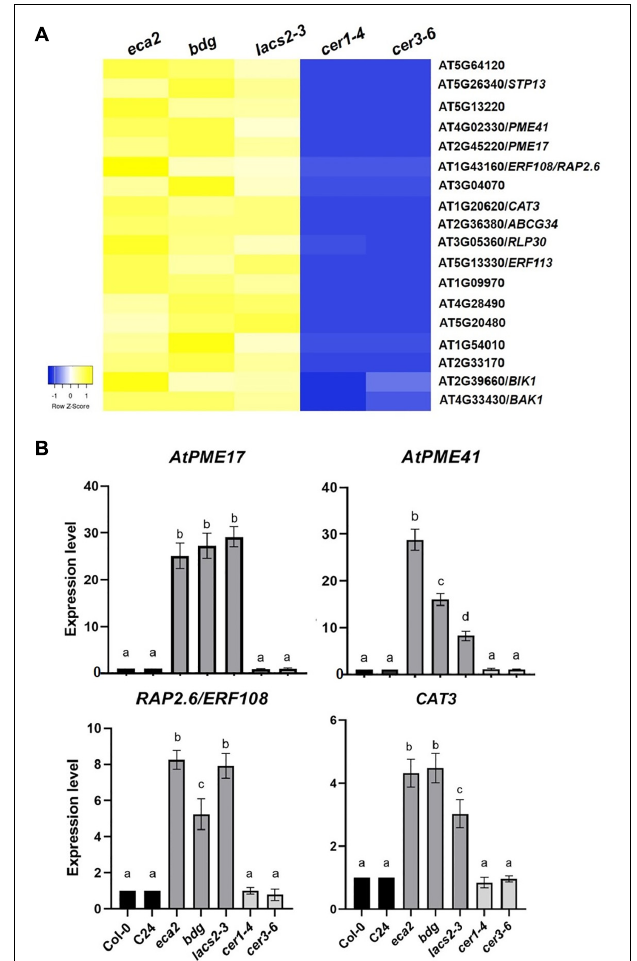
FIGURE 8 | Commonly expressed genes induced in mutants with a reduced level of cutin monomers. (A) Heatmap shows the expression levels of upregulated genes shared by the cutin mutants in response to B. cinerea (6 hpi). The colors of the heat map represent the z-score of the log2FC of each gene ranging from blue (–1) to yellow (1). (B) Expression analysis of some shared up-regulated genes between cutin mutants infected with B. cinerea . Expression levels were determined by RT-qPCR in rosette leaves harvested 6 hpi, based on Ct values, normalized with the expression of the two housekeeping genes. The data represent the means of three independent biological replicates with their respective technical replicates, for each sample. Error bars indicate ± SD. Different letters indicate significance differences among samples according to one-way ANOVA followed by Tukey test ( p ≤